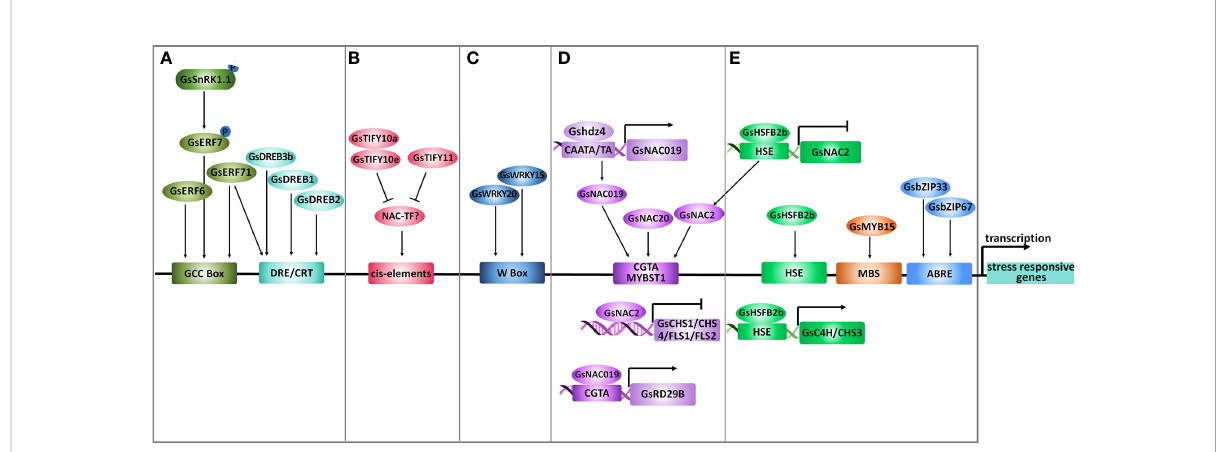
FIGURE 4 Transcriptional regulation under salt-alkaline stress in wild soybean. (A) AP2/ERFs, (B) TIFYs, (C) WRKYs, (D) NACs and (E) other transcription factors mediating the transcriptional response of G. soja to salt-alkaline stress. Arrows represent positive effects, and lines ending with a short bar indicate negative